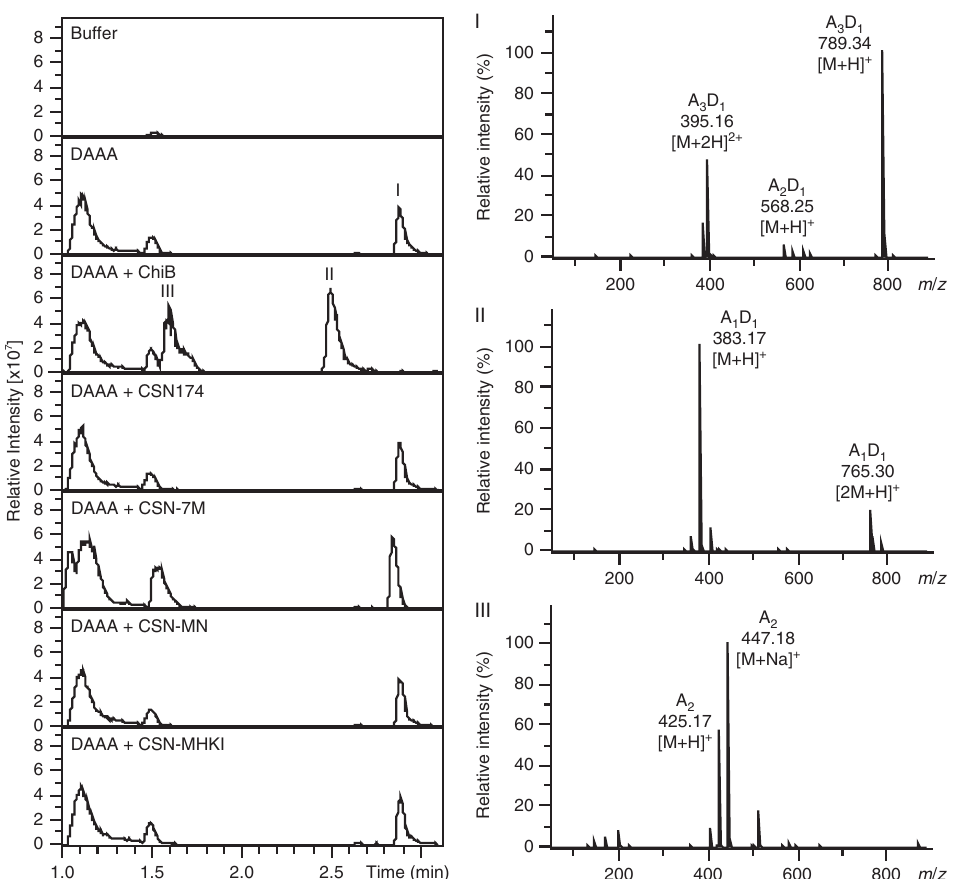
Fig. 6 UHPLC-ESI-MS analysis of the hydrolysis of the oligomer DAAA using different chitosanases and a chitinase. The base peak chromatograms (left) and MS spectra belonging to peaks I – III (right) are shown. DAAA was incubated with the chitosanases (CSN-174, CSN-7M, CSN-MN, and CSN-MHKI) and chitinase B (ChiB) from Serratia marcescens . While ChiB completely hydrolyzed the tetramer DAAA (Peak III) into the dimers AA (Peak I) and DA (Peak II), no activity was observed for any of the